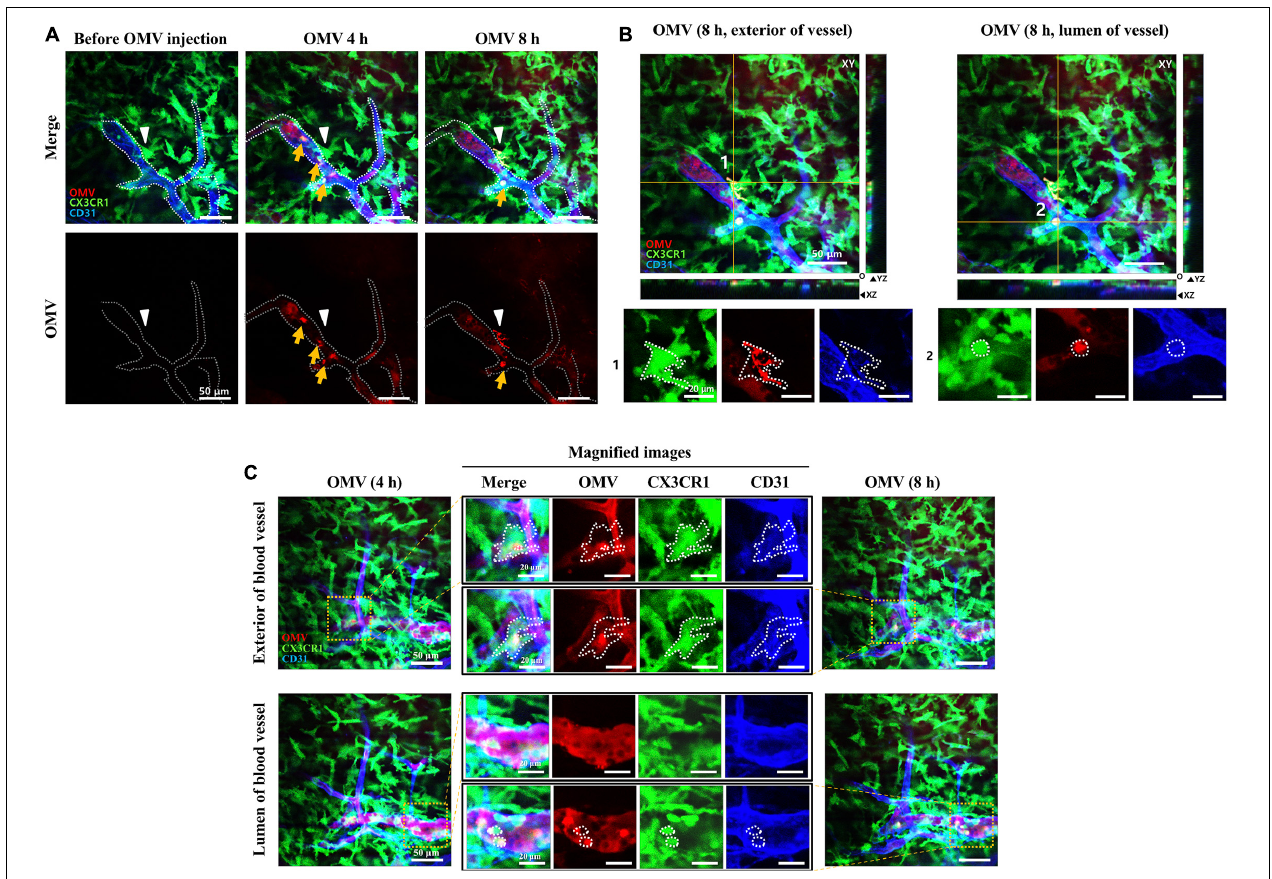
FIGURE 2 | Visualization of tail-vein-injected OMVs and meningeal macrophages of live CX3CR1-GFP mice. (A,B) OMVs taken up by monocytes were compared between 4 and 8 h after OMV injection. Confocal microscopic acquisition results show the OMV distribution before and 4 and 8 h after OMV i.v. injection of mice. (A) The white dotted line delineates the lumen of blood vessels. White arrowheads indicate Aa OMV-colocalized meningeal macrophages, and yellow arrows indicate OMV-colocalized monocytes/macrophages in the lumen of vessel. Scale bar: 50 µ m. (B) Representative image stacks (5 µ m intervals) acquired during confocal imaging of mice with GFP-positive microglial cells for OMVs injected (8 h) shown in (A) . The white dotted area refers to the colocalization of OMVs (red) and CX3CR1-GFP-positive monocytes (green). Scale bar: 50 µ m; magnified scale: 20 µ m. (C) Colocalized monocytes/macrophages (dotted areas in the magnified images) in the exterior and lumen of the meningeal blood vessel were compared. Magnified images (scale bar: 20 µ m) of colocalized monocytes (shown in yellow in the merged images) in the dotted area are clearly seen in both the exterior and lumen of the meningeal blood